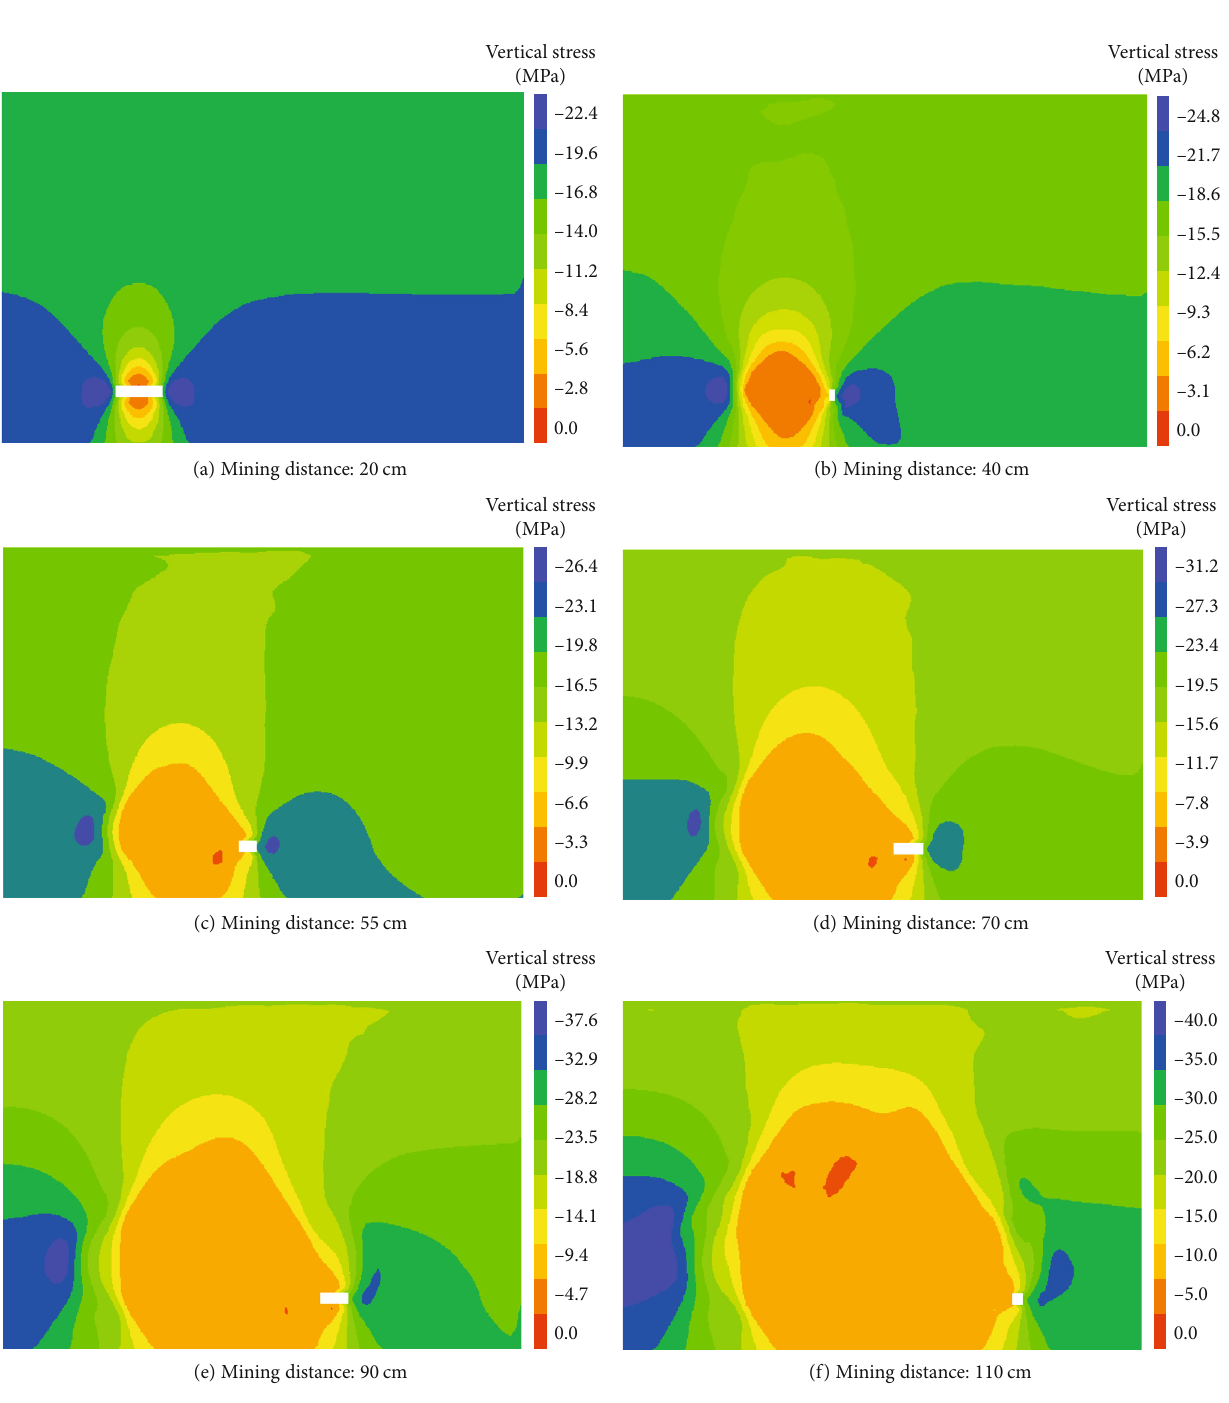
Figure 12: Vertical stress distribution of the extra-thick roof during the advancement of the mining